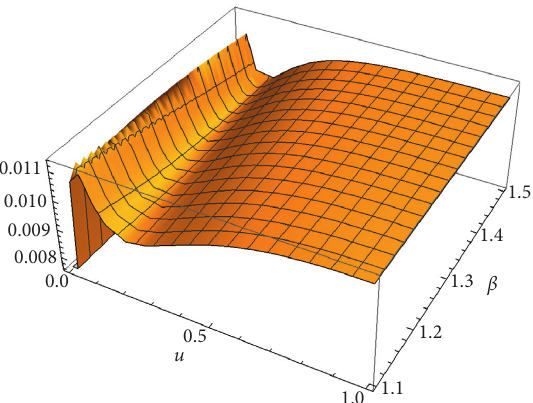
Figure 6: Plot of the difference function F